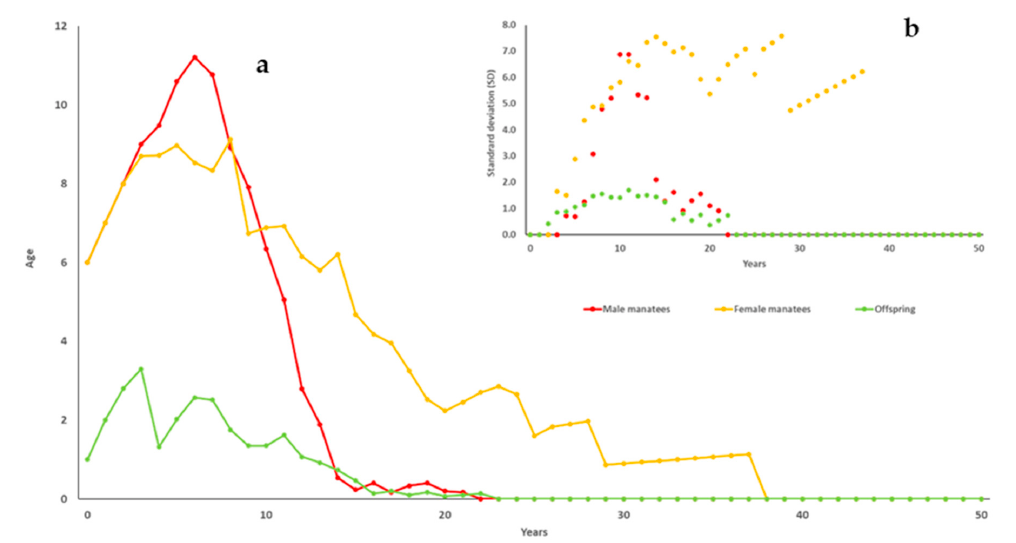
Figure 6. ( a ) The mean age of individuals per year for n = 30 runs; ( b ) the standard deviation of the mean age individuals per year for all the runs ( n = 30).